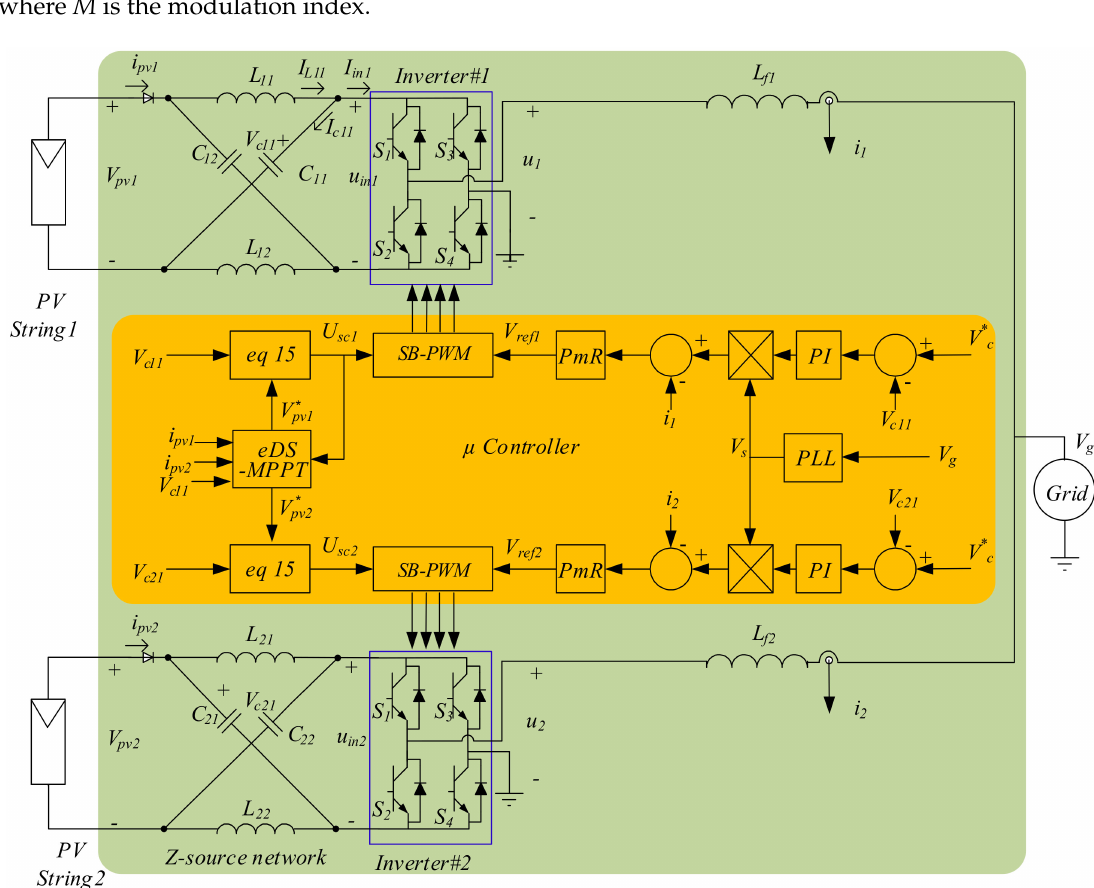
Figure 3. Configuration of the proposed